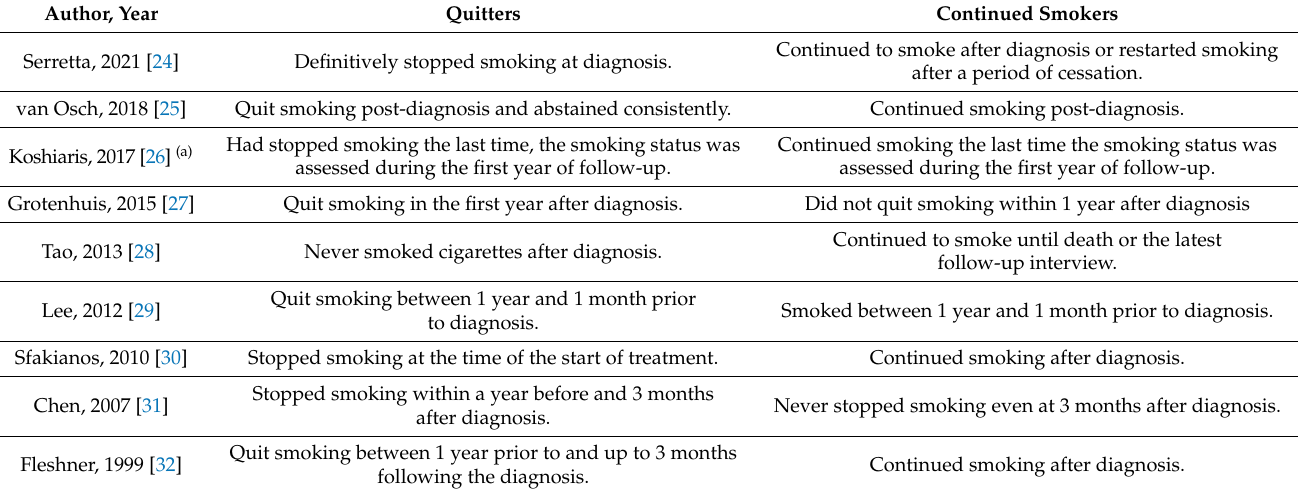
Table 2. Definition of quitters and continued smokers in the studies included in the systematic review and meta-analysis on the prognostic effect of quitting smoking at or around diagnosis on the survival of bladder cancer